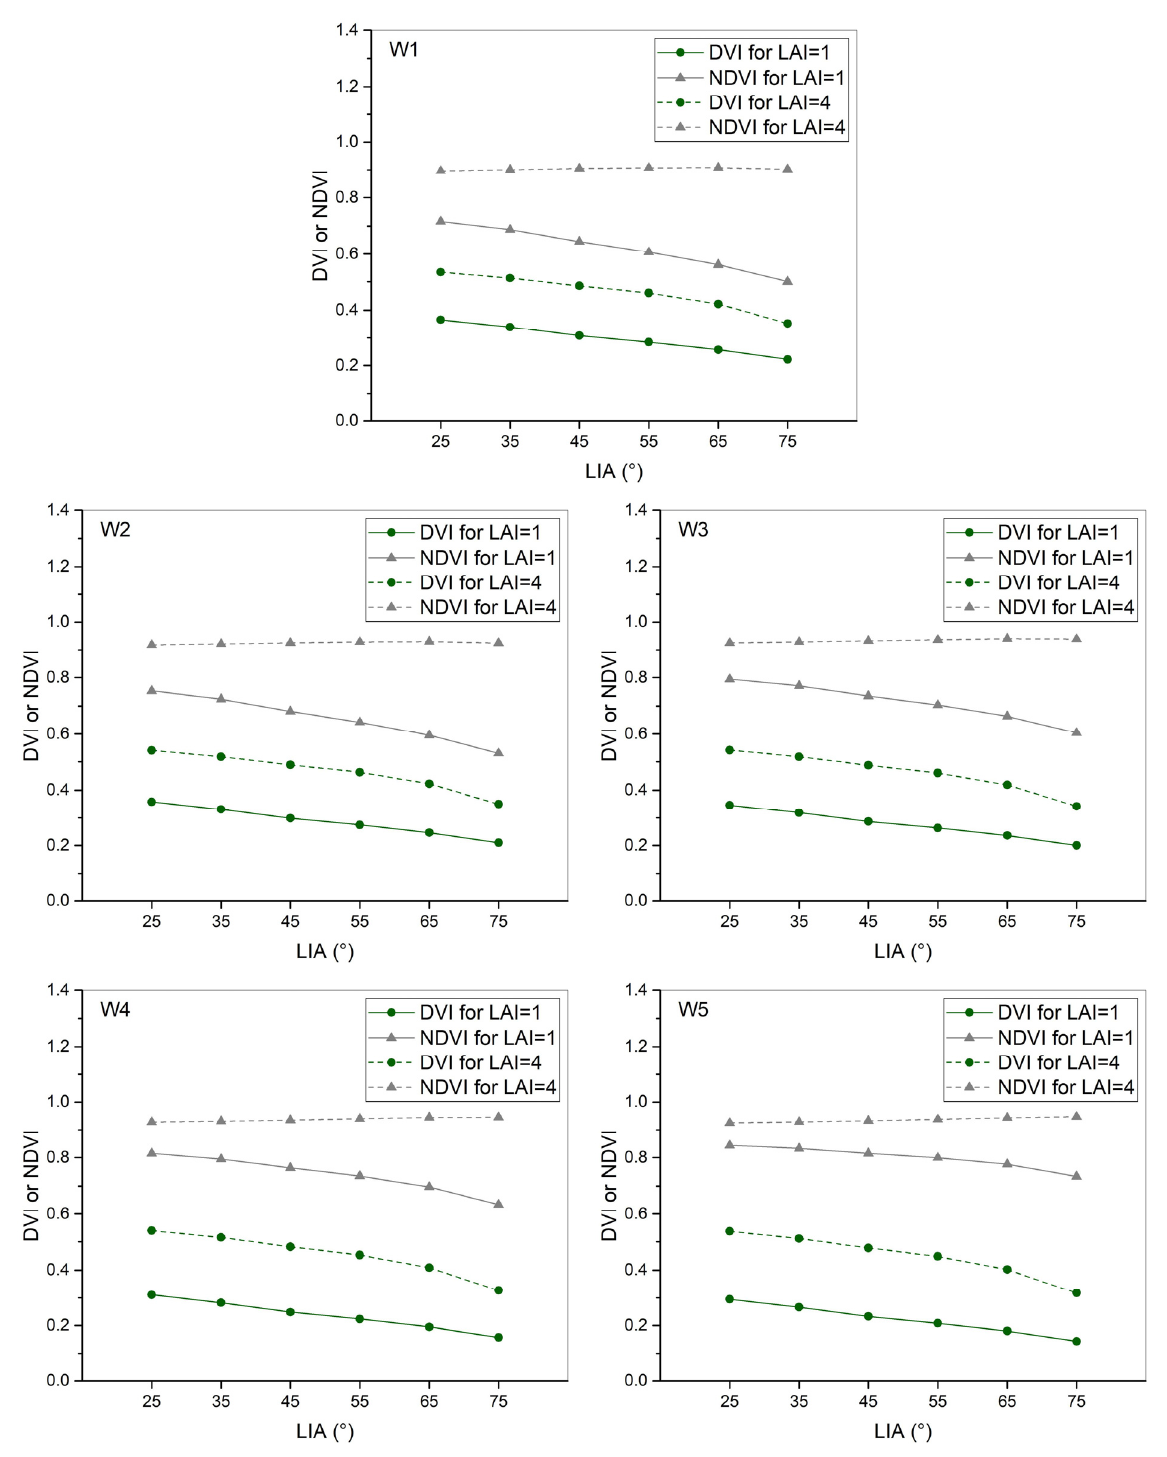
Figure 10. Effects of different LIA on vegetation index under continuous water stresses.